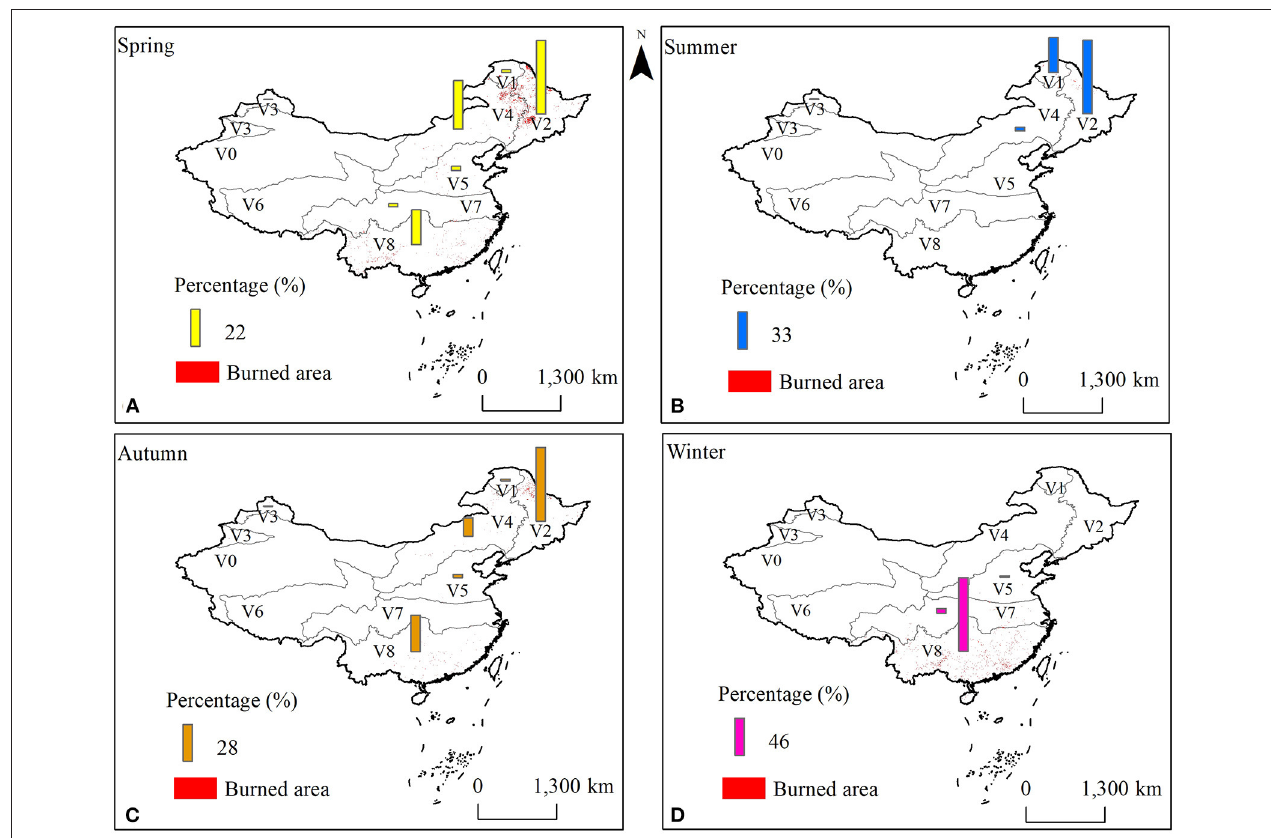
FIGURE 5 | Percentage of burned area in different seasons. (A) percentage of burned area in spring; (B) percentage of burned area in summer; (C) percentage of burned area in autumn; (D) percentage of burned area in